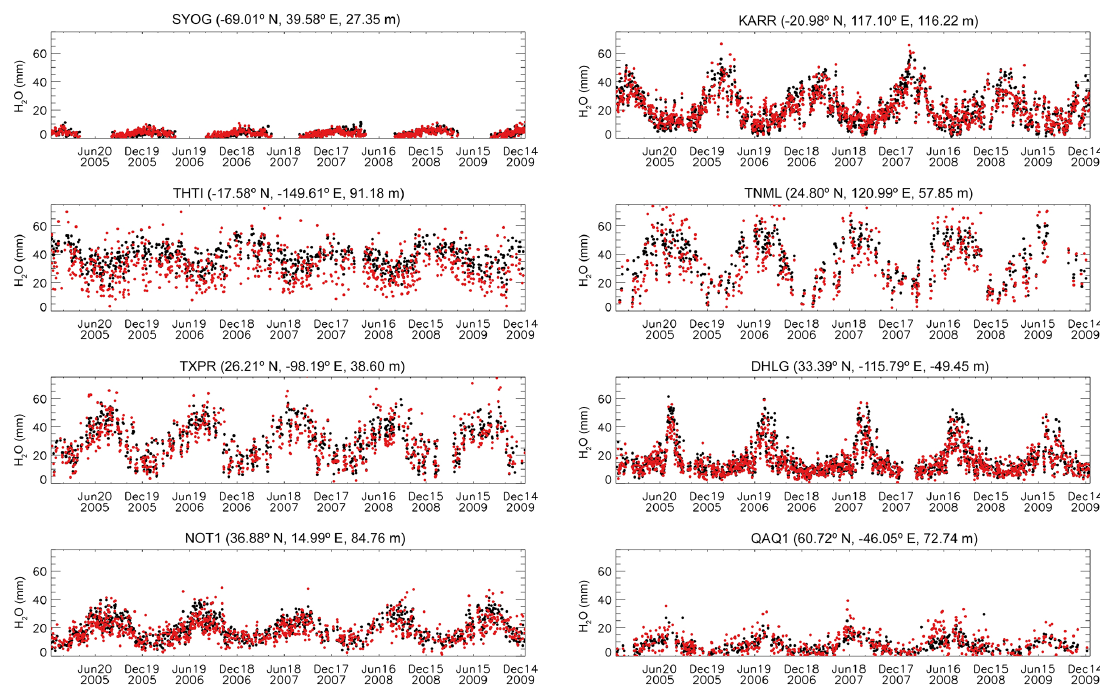
Figure 2. Time series comparison between the version 1.0 OMI (red) and GPS (black) data at selected GPS stations from 1 January 2005 to 31 December